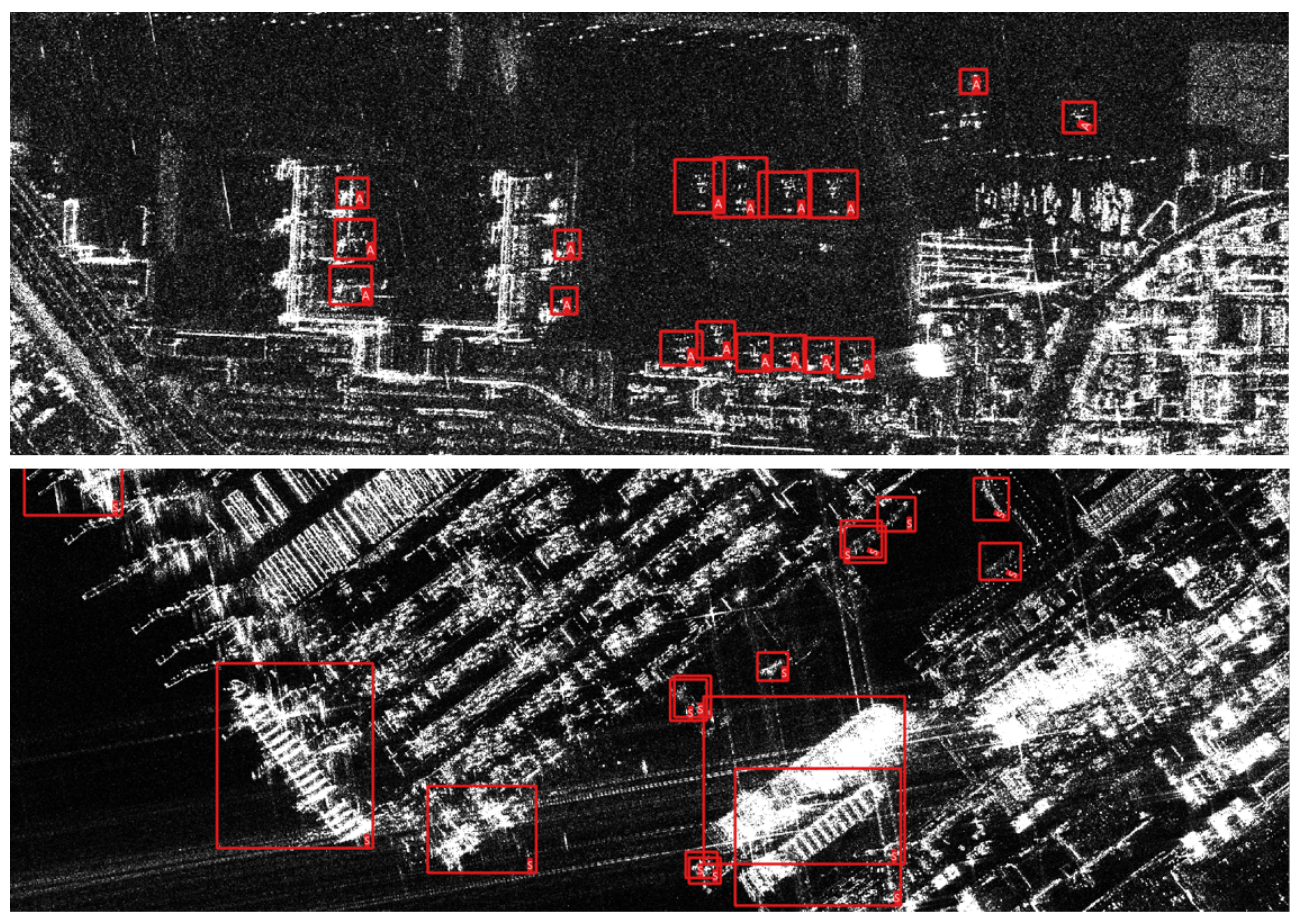
Figure 3. Example airplane (top) and ship (bottom) objects in COSMO-SkyMed image. The groundtruth bounding boxes labeled as corresponding class are plotted in red color.